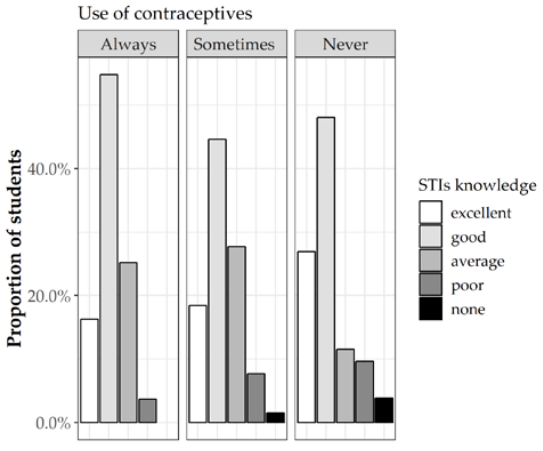
Figure 4. Percentage of the students’ reported source for information on sexuality.